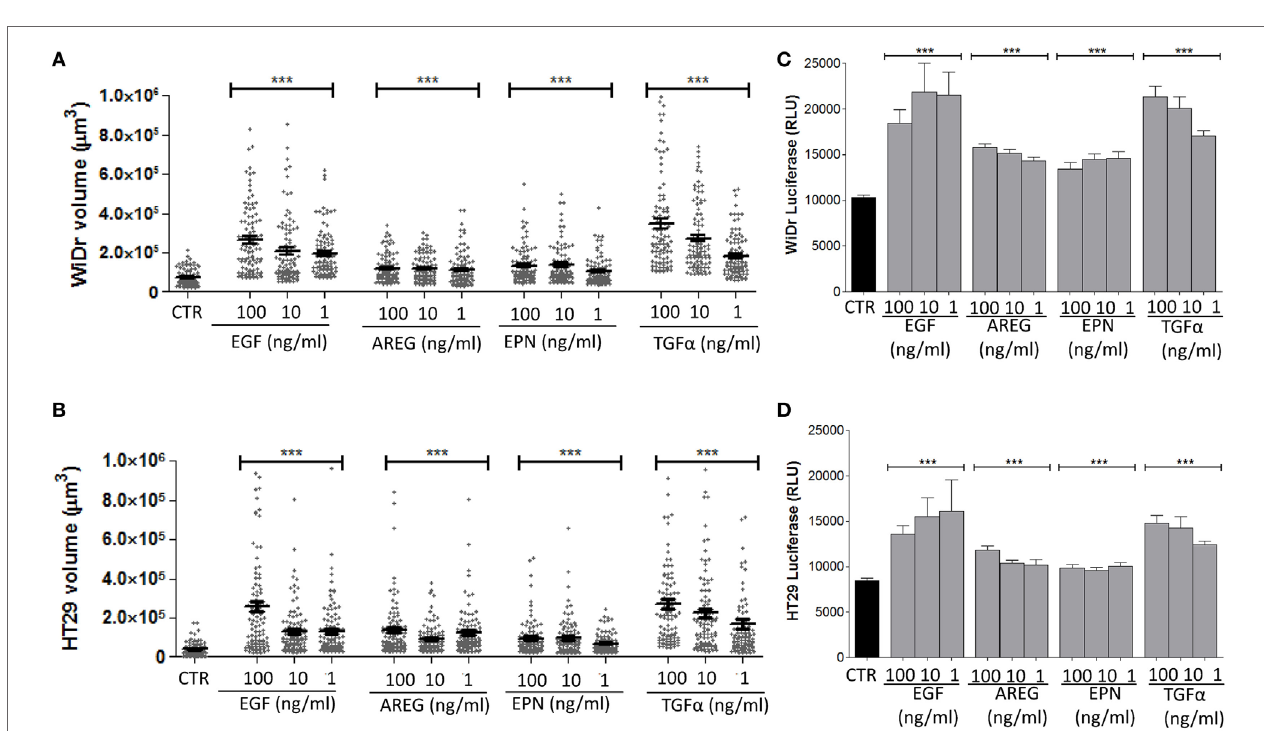
FIGURe 4 | Effect on spheroid size of different epidermal growth factor receptor ligands. (A,B) CRC cell lines [WiDr (A) ; HT29 (B) ] were cultured in serum free medium (SFM) without (CTR) or with 100-10-1 ng/ml of epithelial growth factor (EGF), amphiregulin (AREG), epiregulin (EPN), or transforming growth factor- α (TGF α ), in very low adherent 96-well flat-bottomed microplates. Cell cultures were analyzed on day 6 by inverted IX70 microscope (Olympus) and images were taken with 10 × objective NA 0.30 (100 × magnification). Each symbol in the different plots indicates a spheroid. Data are shown as volume ( μ m 3 ). Bar: mean ± SEM of that group of measures. *** p < 0.0001. (C,d) ATP content of the same cultures, expressed as luminescence of luciferase activity. Black columns indicate the ATP content of cells cultured in SFM and gray columns the ATP content of cell cultured in the presence of the indicated factors. Data are the mean ± SD of 6-well replicates for each culture condition. *** p < 0.001.